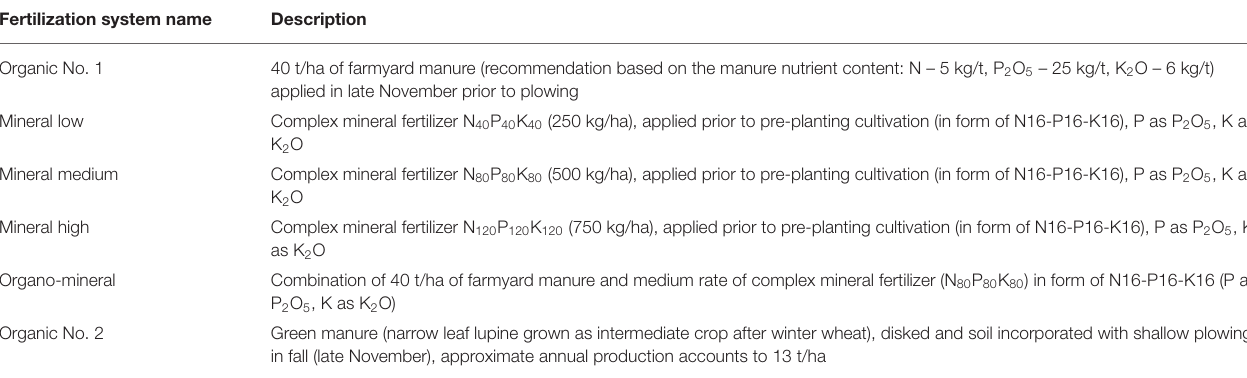
TABLE 1 | The description of the fertilization systems used in the experiment. Fertilization system